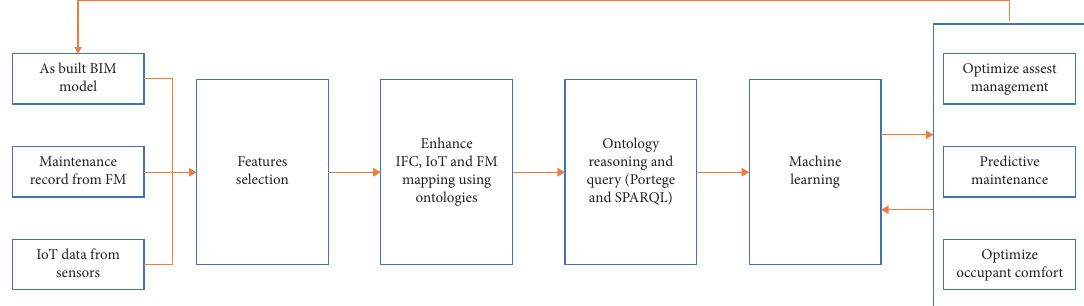
Figure 10: A preliminary architecture for information integration based on